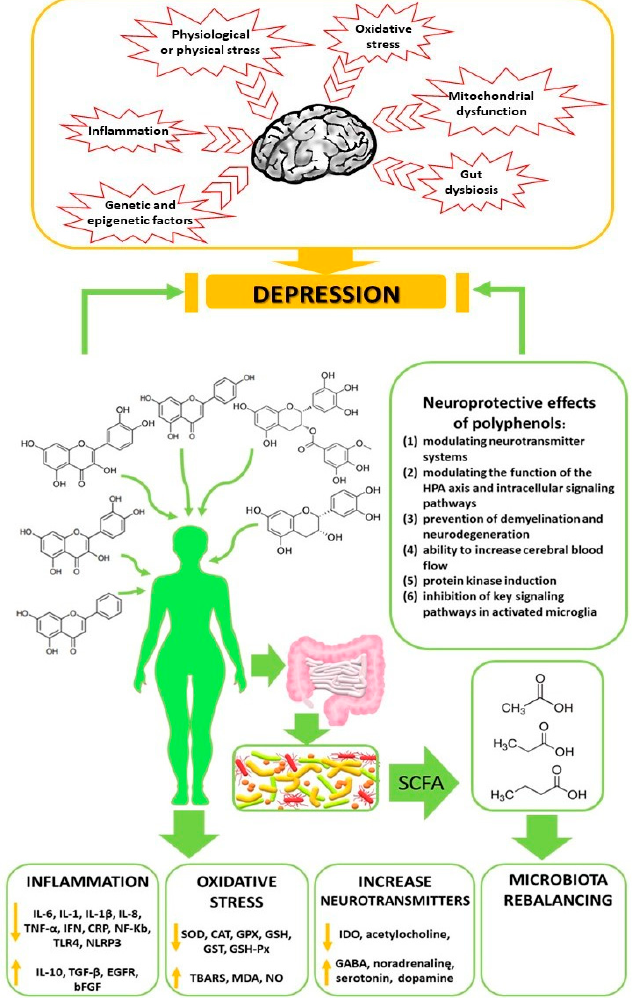
Figure 3. Beneficial effects of dietary polyphenol consumption on the reduction of depression.